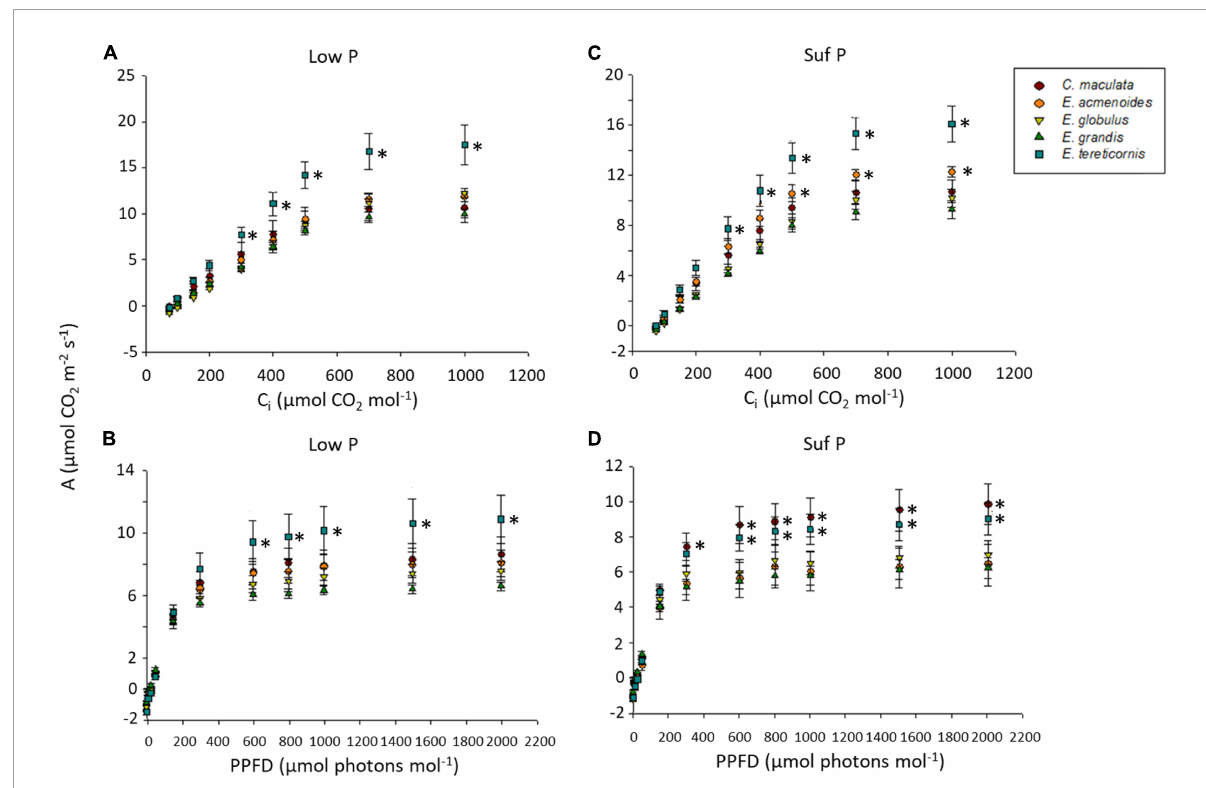
FIGURE2 Curves of CO 2 -assimilation rates of five eucalypt species cultivated in soil with low (Low P) or sufficient (Suf P) phosphorus availability. CO 2 -assimilation rate ( A ) as a function of intercellular CO 2 concentrations ( C i ) (A,C) and CO 2 -assimilation rate ( A ) as a function of photosynthetic photon flux density (PPFD) (B,D) . Asterisks on the right side of symbols indicate a statistical difference between the species (symbol) and E. grandis , according to the Scott Knott test ( P <